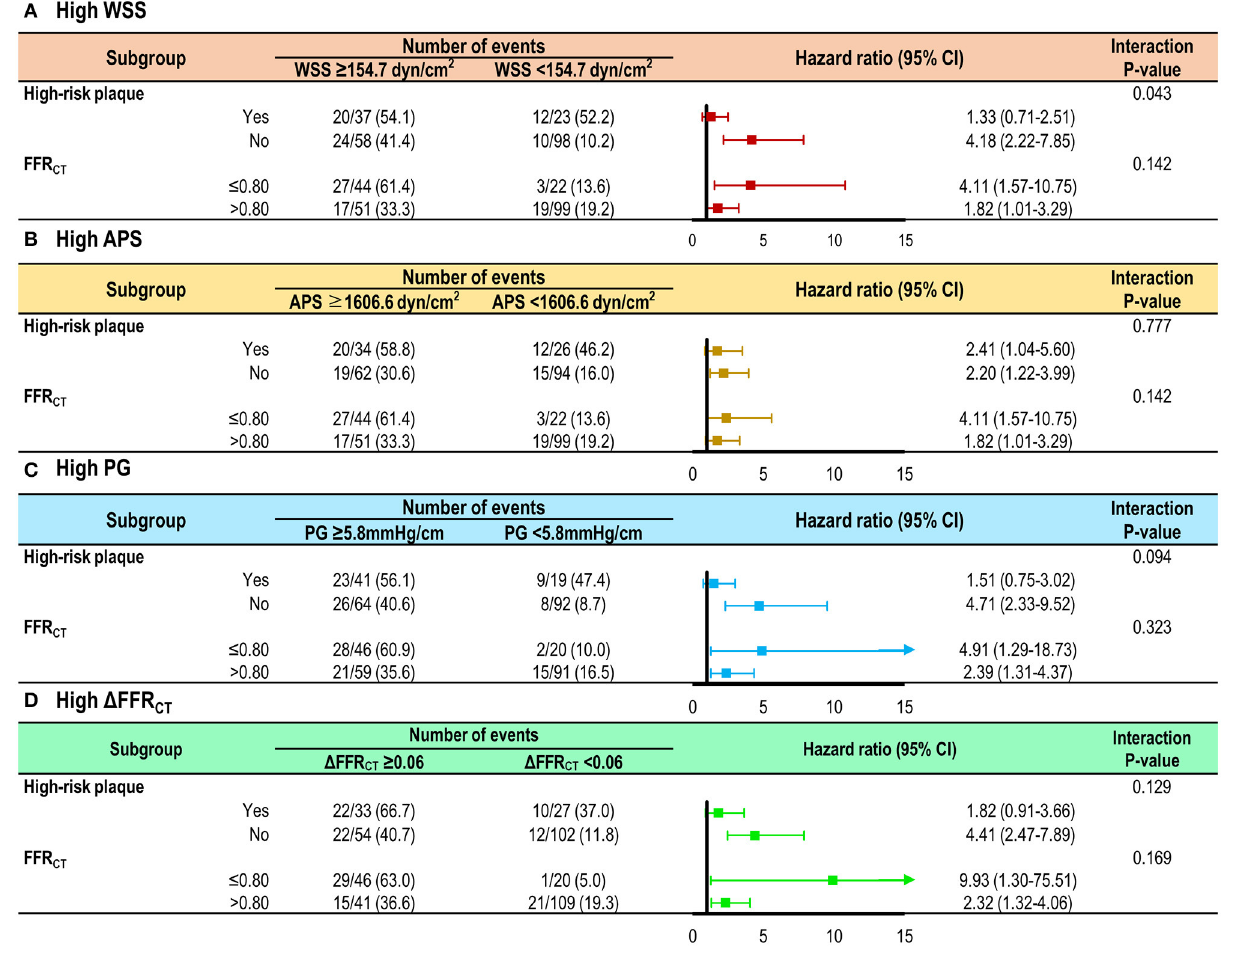
FIGURE 4 | Risk of culprit lesions according to local hemodynamic parameters in the subgroups by high-risk plaque or FFR CT . The risk of culprit lesions according to (A) high WSS, (B) high APS, (C) high PG, or (D) high 1 FFR CT is shown in lesions with and without high-risk plaque and FFR CT ≤ 0.80. A trend toward an increased risk of culprit lesions was consistently observed in lesions with high WSS, high APS, high PG, or high 1 FFR CT , independent of the presence of high-risk plaque and FFR CT ≤ 0.80. The definition of high-risk plaque was the same as in Figure 3 . APS, axial plaque stress; FFR CT , coronary computed tomographic angiography-derived fractional flow reserve; PG, pressure gradient; WSS, wall shear